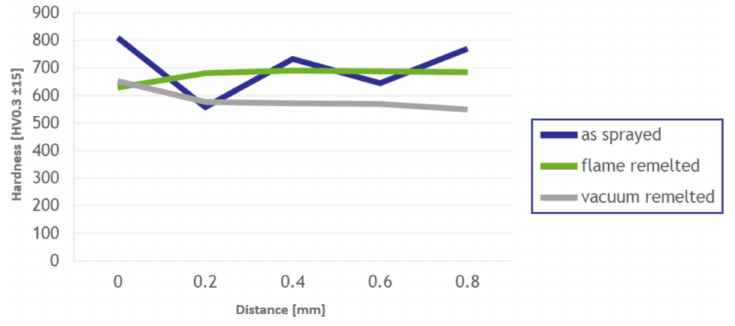
Figure 8. Graph highlighting the variation of the HV0.3 microindentations along the coating.